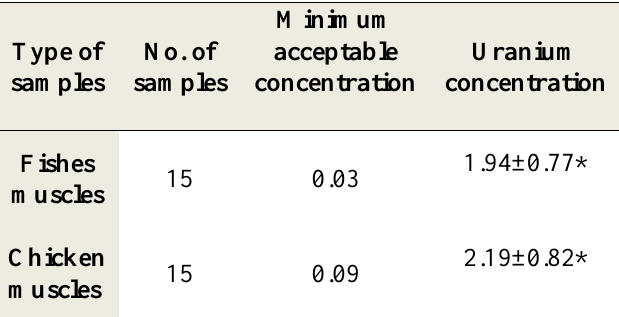
Table 1. The mean±SD of uranium concentration